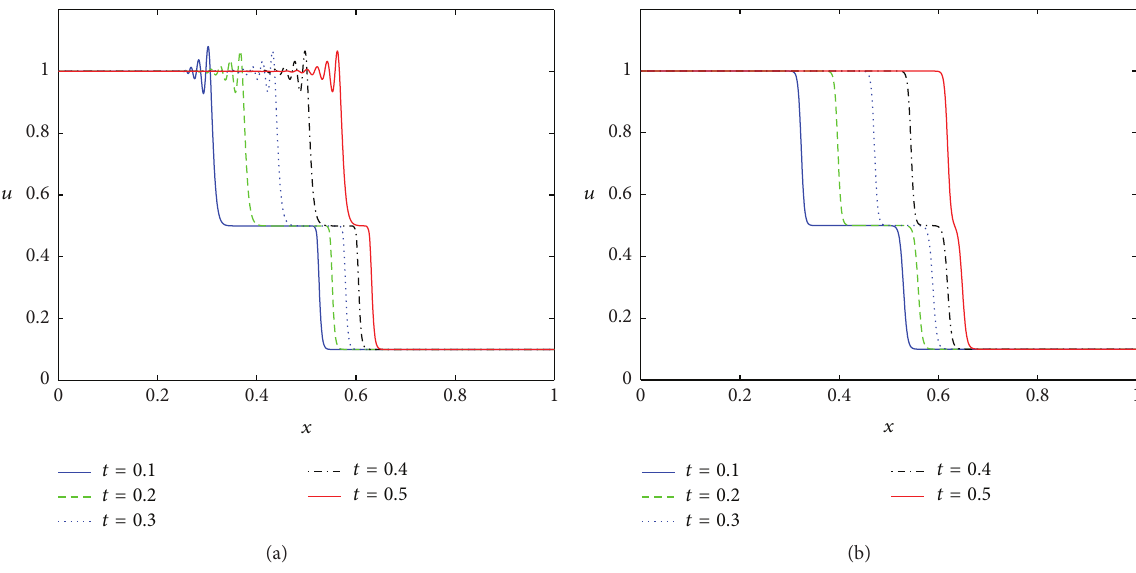
Figure 2: The numerical solutions of Re = 2000 obtained by VMEFG method with and without filter, respectively. (a) is obtained without filter and (b) is with low-pass filter.